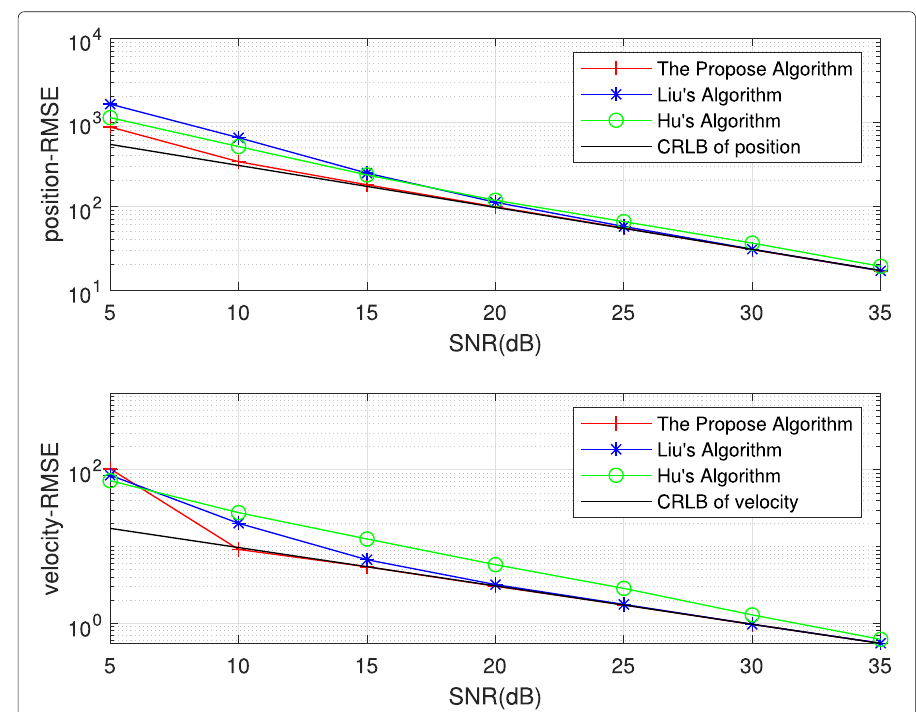
Fig. 3 RMSE comparison of three algorithms for the far field